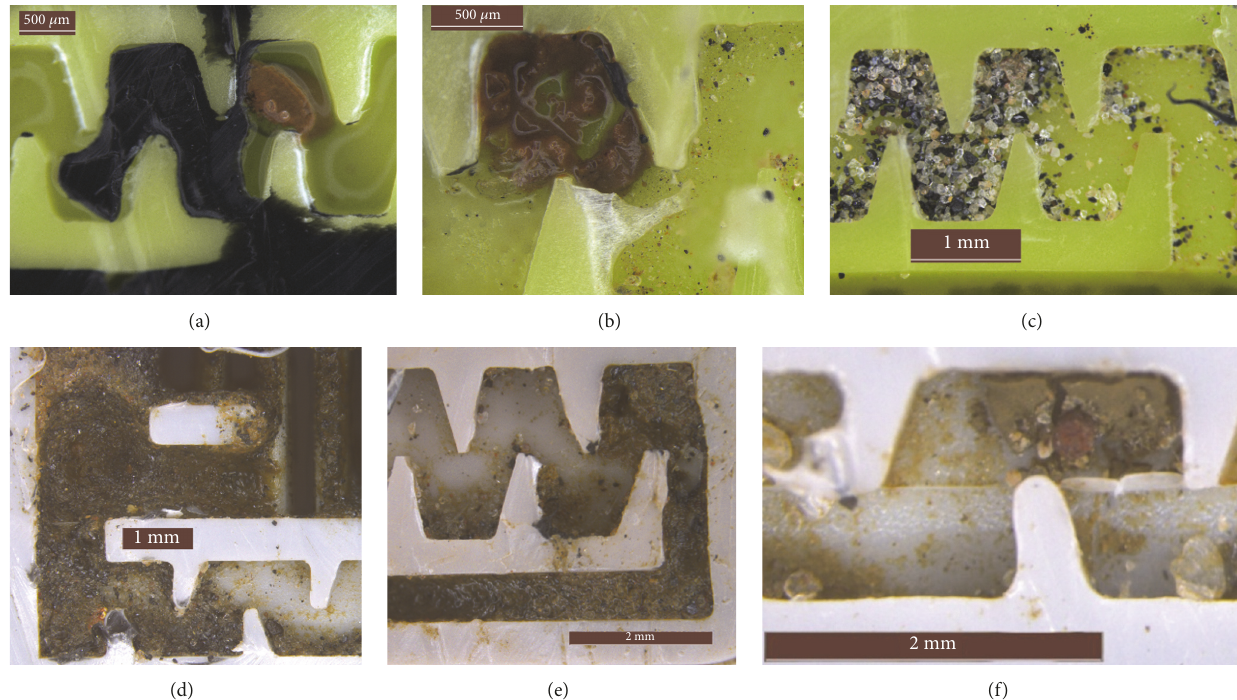
Figure 3: Blockage of the flow path due to the aggregation of fine particles drippers A1 ((a) and (b)). Deposition of big particles within drippers A1 (c). Deposition of particles at the labyrinth inlet and at channel corners for drippers B2 ((d) and (e)). Deposition of particles within B2 due to the molding imperfections of drippers